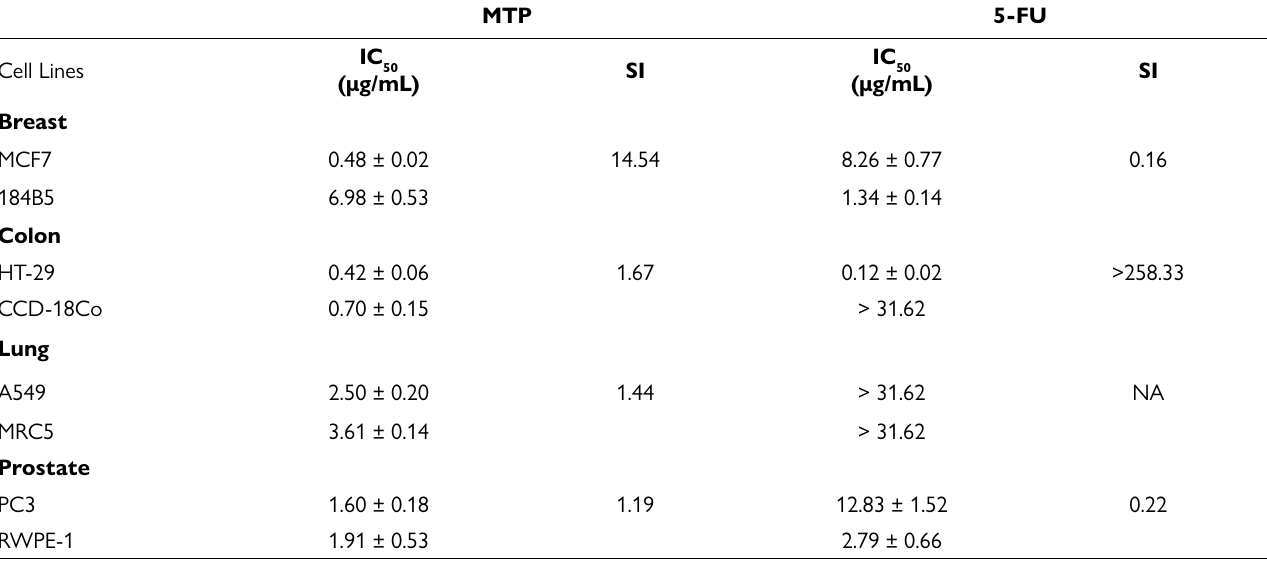
) (µg/mL) and selectivity indices (SI) of Malaysian T. purpureomaculatus (MTP) venom for different cell lines after Table 1. Median inhibition concentrations (IC 50 72-hour treatment in comparison to 5-fluorouracil (5-FU).